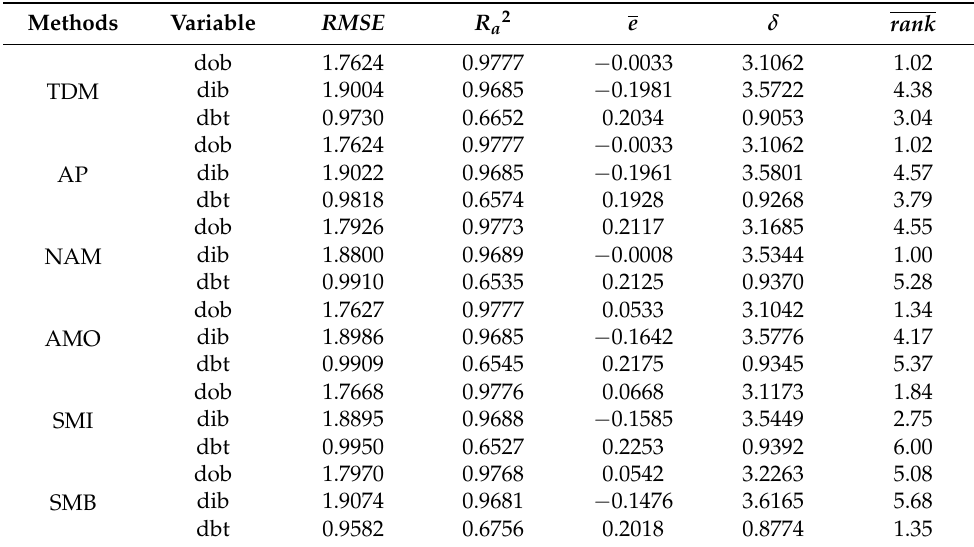
Table 3. Goodness of fit statistics of five additive models.